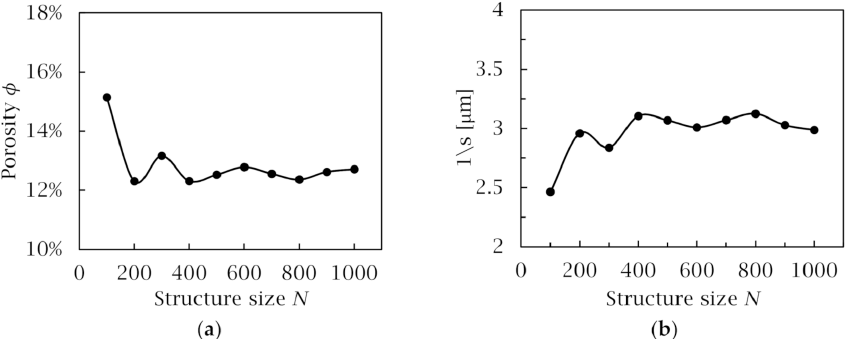
Figure 4. Results of ( a ) porosity φ and ( b ) reciprocal of specific area s change with structure size N .